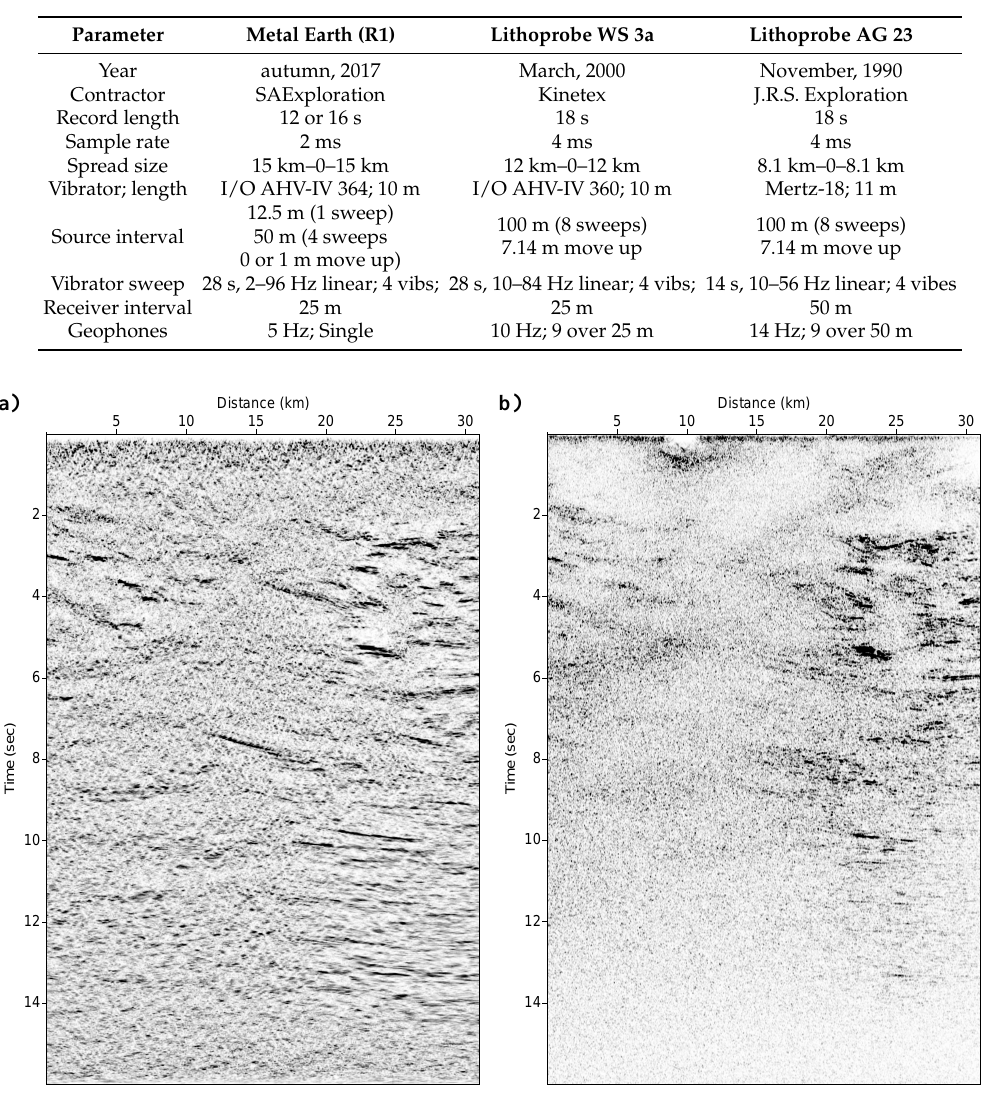
Table 4. Comparison of acquisition parameters used in Metal Earth and Lithoprobe surveys.